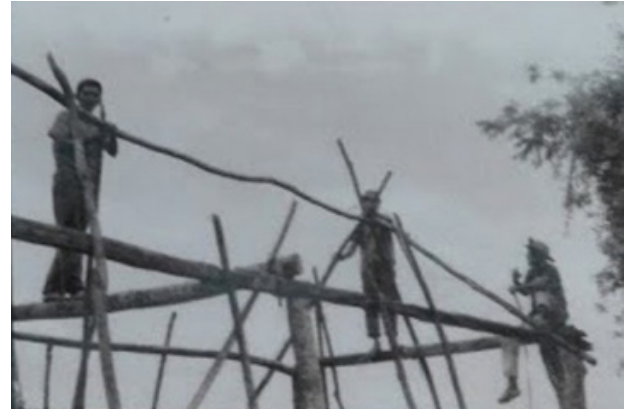
Figure 1. Old picture of a vernacular construction in Cordoba. Centro de Documentación Regional Orlando Fals Borda-Banco de la República Montería. Folder p. 23 [2].